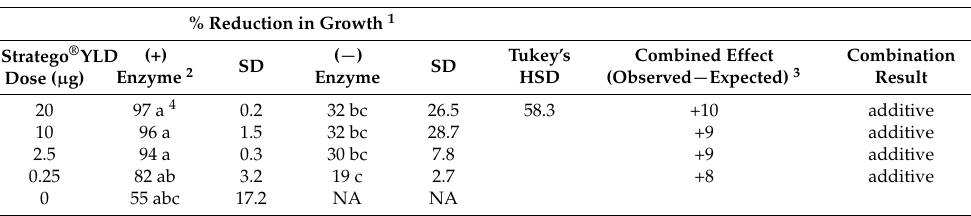
Table 4. Inhibition of Fusarium graminearum by the stabilized LPO formulation alone and in combination with Stratego ® YLD using fungicide-impregnated filter paper disks.